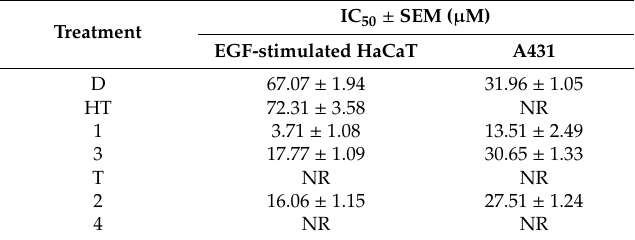
Figure 2. Effects induced by test compounds on cell viability of HaCaT cells after stimulation with 5 ng/mL EGF ( A , B ) and A431 cells ( C , D ). Cells were exposed to compounds for 72 h and cell viability assessed by neutral red assay. Data are expressed as means ± SEM of three independent experiments, each performed in triplicate. Each hybrid was compared to single agents. D: diclofenac, HT: hydroxytyrosol, T: tyrosol. Table 1. IC 50 mean values ± Standard Error of the Mean (SEM) for test compounds on EGF-stimulated HaCaT and A431 cell lines 1